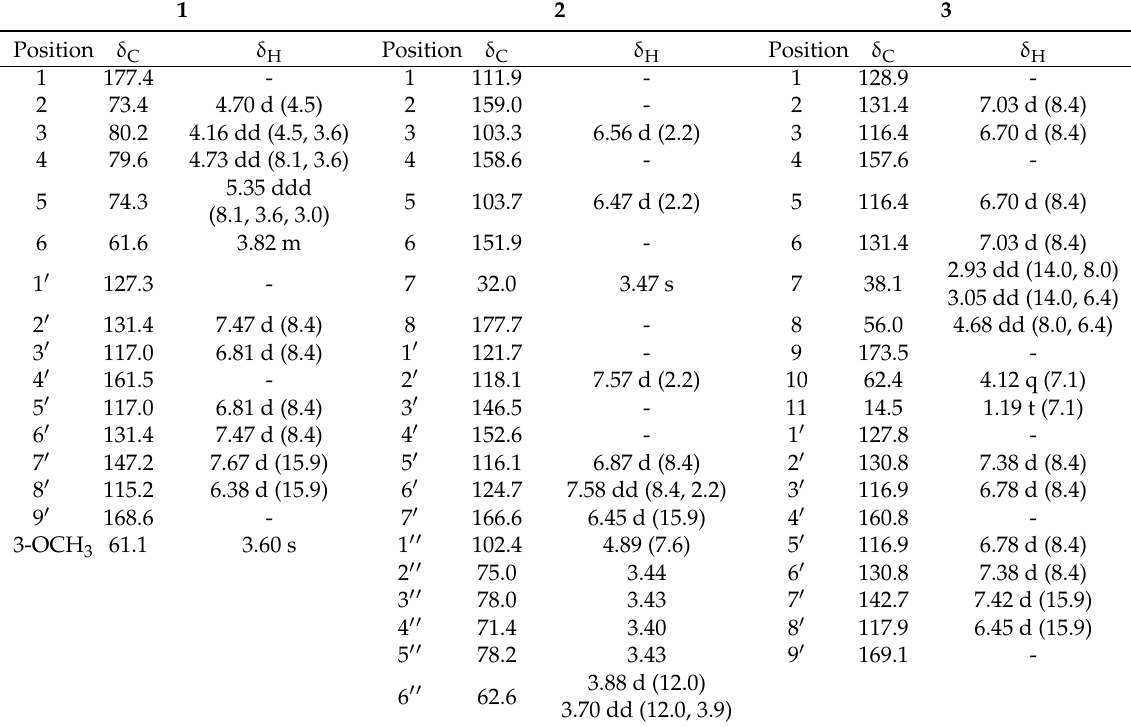
Table 1. 1 H- and 13 C-NMR data of 1 – 3 (in CD 3 OD, J in Hz) a,b